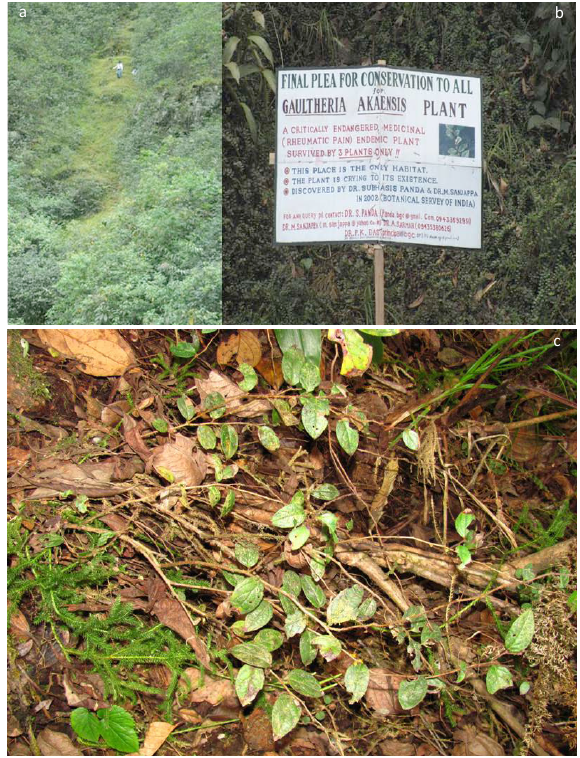
creating awarness for conservation; c - present condition of the species at its natural habitat (January 2011)